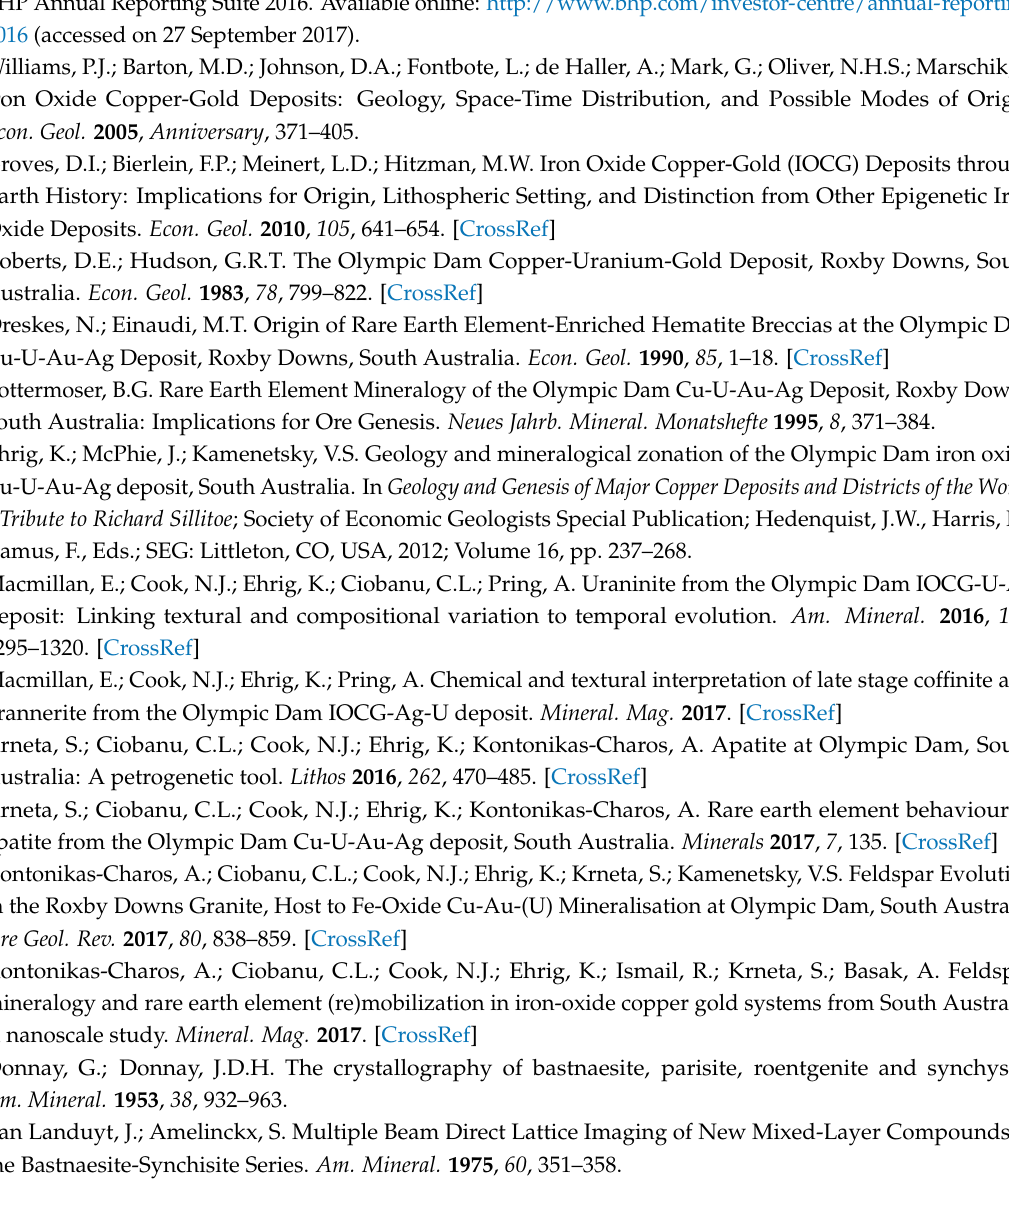
Table S2: Full details of analytical set-up for EPMA analysis, Table S3: Full EPMA standard list, Table S4: Full Table S6: Full LA-ICP-MS dataset for REE-fluorocarbonates; Figure S1: Detailed images of the sample set, Figure S2: Examples of LA-ICP-MS downhole laser